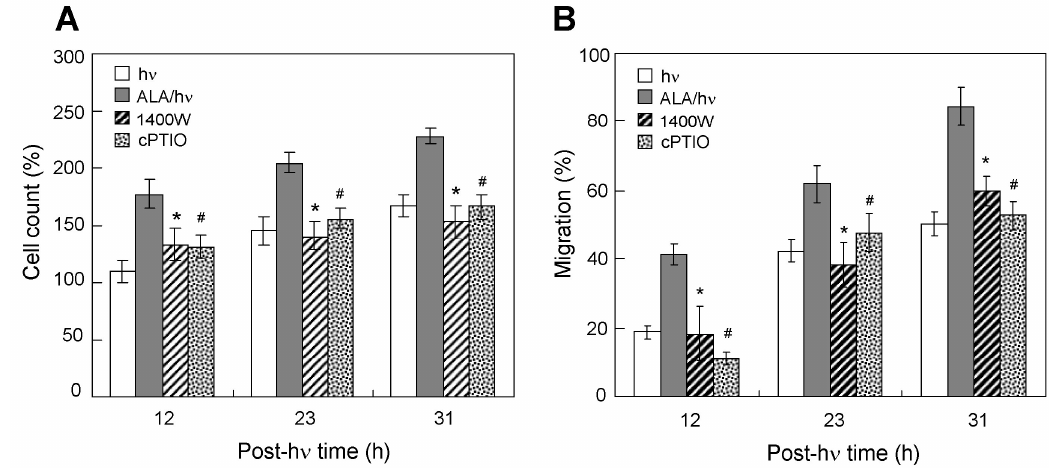
Figure 4. Effects of an iNOS inhibitor or NO scavenger on proliferation and migration of MDA-MB-231 bystander cells exposed to ALA/light-targeted counterparts. After sensitization with ALA-induced PpIX, target cells (separated from ring-enclosed bystanders) were switched to fresh medium without ALA, then exposed to a light fluence of 0.2 J/cm 2 as described in Figure 3. A non-ALA-treated control was irradiated alongside. After a 1 h dark period, the separating rings were removed, and cells were switched to 10% serum-containing medium. Where indicated, 25 µM 1400 W (W) or 25 µM cPTIO (cP) was included in both cell compartments before irradiation and maintained at this concentration during subsequent dark incubation. ( A ) Bystander proliferation during post-irradiation incubation of both cell populations. Cell counts were determined via Image-J analysis; plotted values are means ±SEM ( n = 6); ( B ) Bystander migration during post-irradiation incubation, as determined by gap-closure assay; means ±SEM ( n = 5). ( A ) and ( B ): * p < 0.05 vs. ALA/h ν ; # p < 0.05 vs. ALA/h ν .